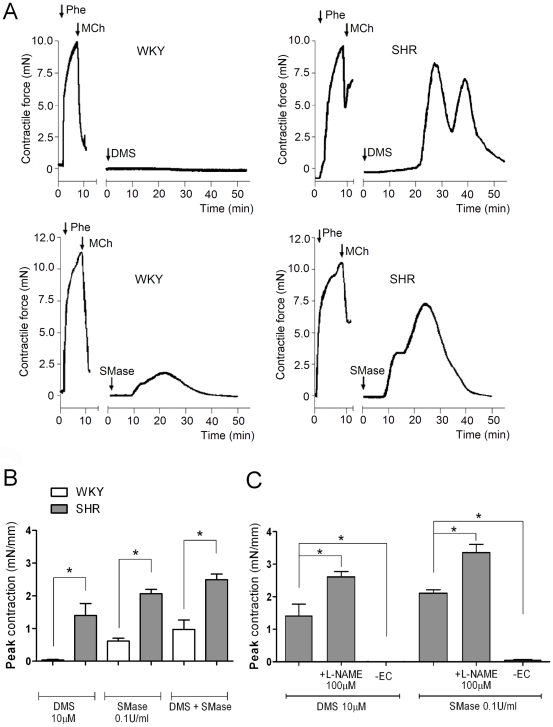
DMS-induced and SMase-induced contraction in SHR and WKY carotid artery.A) Original tracing of rat carotid artery segments exposed to DMS (10 µmol/L) or SMase (0.1 U/mL). Note reduced relaxing response to MCh (10 µmol/L) in SHR, indicating pronounced endothelial dysfunction. B) Maximal contractile responses to DMS and/or SMase in intact WKY and SHR vessels and C) SHR vessel responses in the presence of L-NAME or endothelium-denudation (-EC). Phenylephrine (Phe), methacholine (MCh), dimethylsphingosine (DMS), sphingomyelinase C (SMase), Nω-Nitro-L-arginine methyl ester (L-NAME). Data presented as mean ± SEM, n = 5–6, (*) p<0.05.